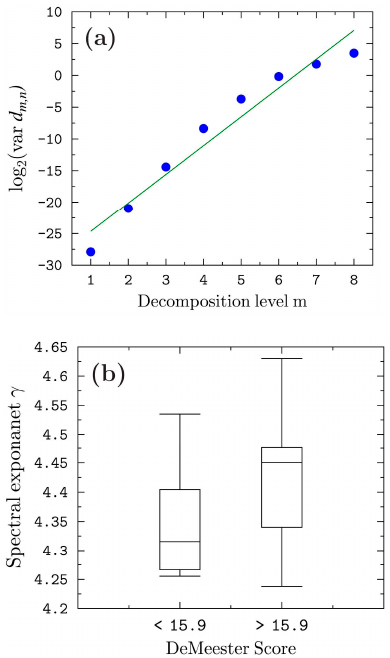
Figure 11. The calculation results of the spectral exponent γ and its statistical representation. ( a ) Distribution of the spectral exponent γ illustrated as a function of the decomposition level (the dashed line represents a trend line calculated by the method of least squares). ( b ) The minimum and maximum values of the spectral exponent gamma together with the first, second, and third quartiles associated with the two groups of patients.